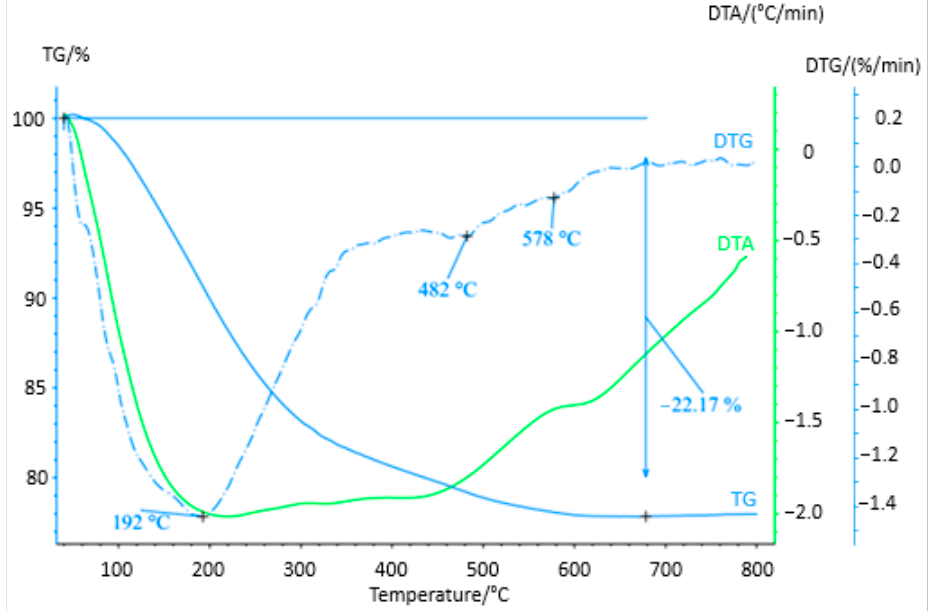
Figure 7. TGA analysis of the solid product of the EC process obtained from the model solution c(Cr(VI) = 2500 mg/L), c(NaCl) = 3000 mg/L, pH = 6, I = 0.1 A.